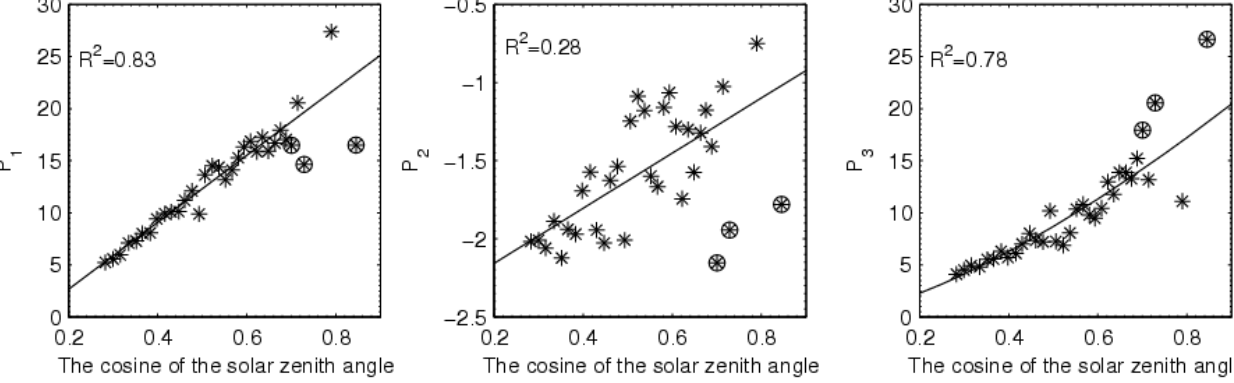
Figure 3. The dependence of UV radiation on aerosol optical depth at 500 nm for nine